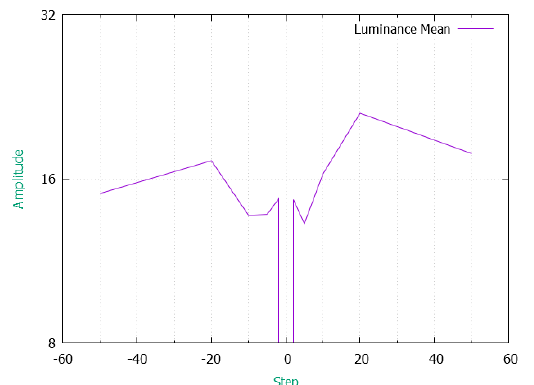
Figure 13. Plot luminance variance 64x64 px